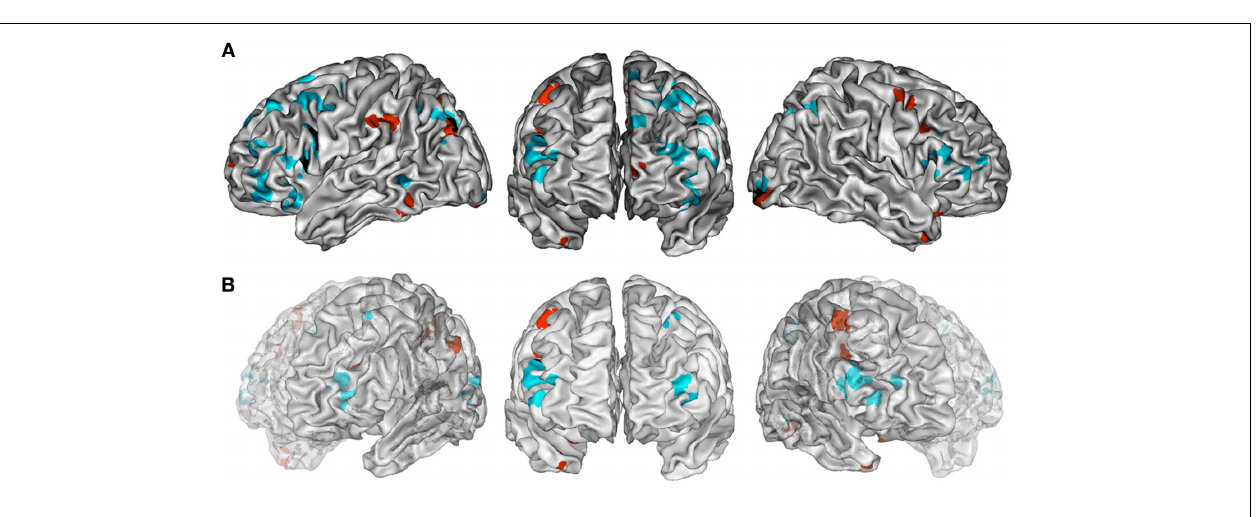
cyan) and generation vs. combination task foci (in red). These contrast maps were thresholded at a whole-brain FDR corrected p < 0 . 05. In (A,B) , ALE maps are displayed on a surface rendering of the Colin27 template (Holmes et al., 1998) in the MNI